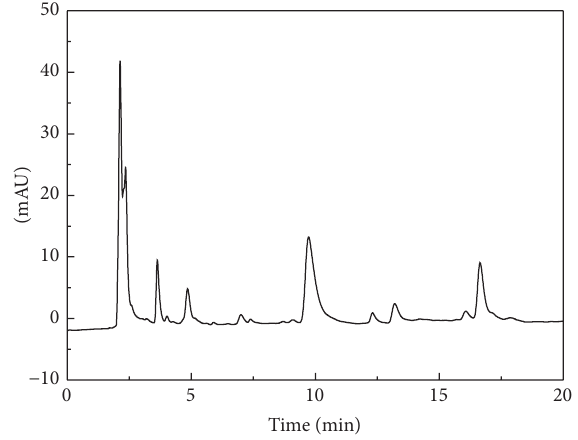
Figure 8: HPLC chromatogram of